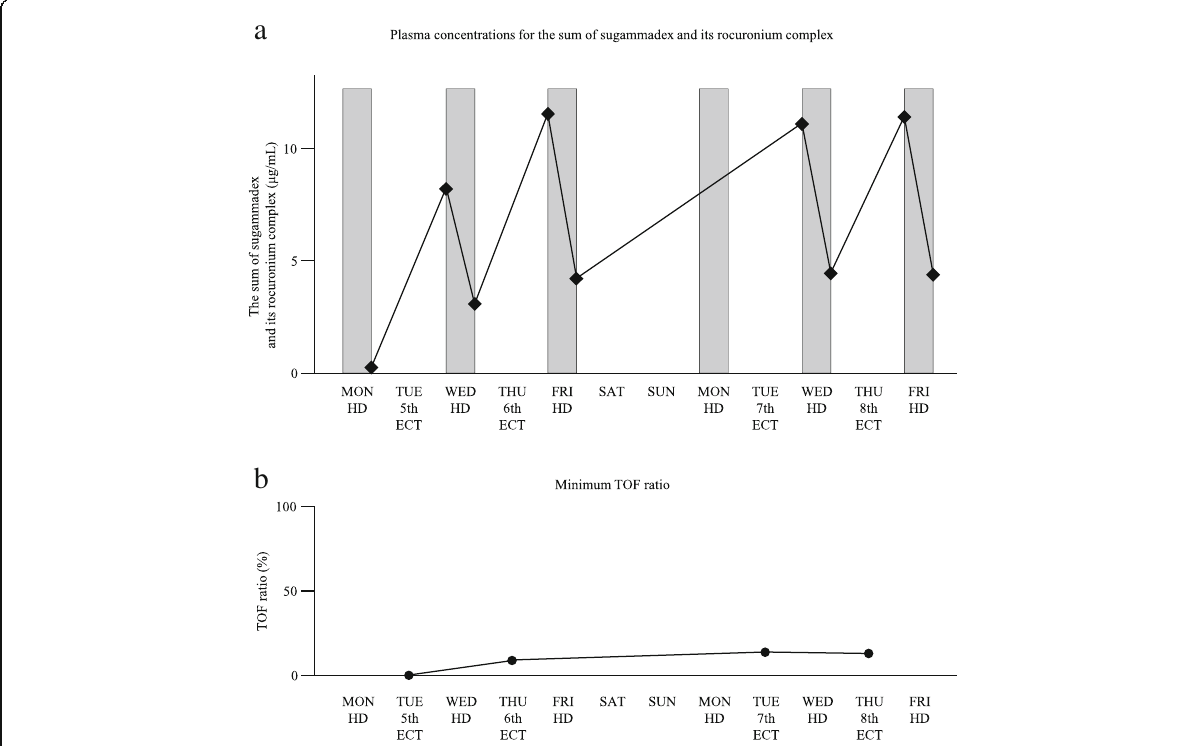
Fig 1 a Plasma concentrations for the sum of sugammadex and sugammadex-rocuronium complex. Gray bars represent hemodialysis, and black diamonds show the concentration before and after hemodialysis. b Minimum train of four ratio immediately before electroconvulsive therapy. HD hemodialysis, ECT electroconvulsive therapy, TOF train of